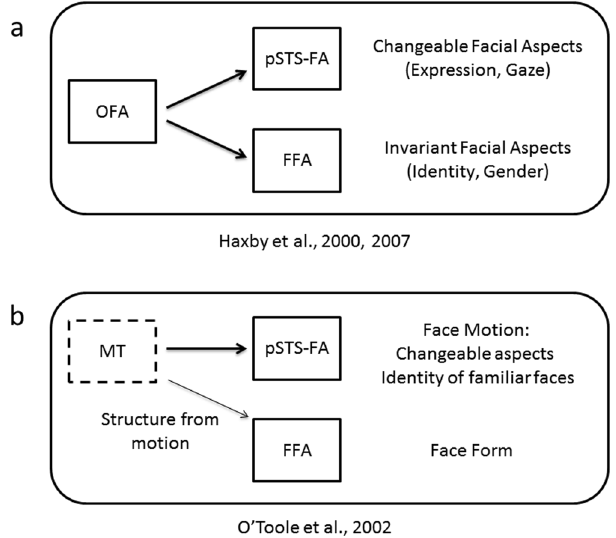
Figure 1. Neural models of face processing. ( a ) The current dominant neural model of face processing 1,4 includes two pathways: a ventral pathway, including the FFA, processes invariant facial aspects, such as identity and gender, whereas a dorsal pathway, including the pSTS-FA, processes changeable facial aspects such as facial expression and eye gaze. The OFA is involved in early stages of face processing and provides input to both pathways. ( b ) Modifications to this model for dynamic faces 8 : the ventral pathway processes facial form while the dorsal pathway processes facial motion. The motion-selective area MT provides input to the dorsal, motion pathway, and may also send “motionless” structure information to the ventral, form pathway.